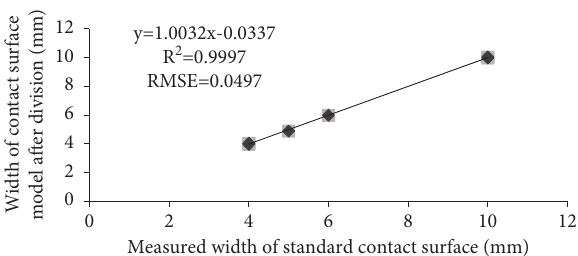
Figure 11: Accuracy analysis of the segmentation model of the fatigue roller contact